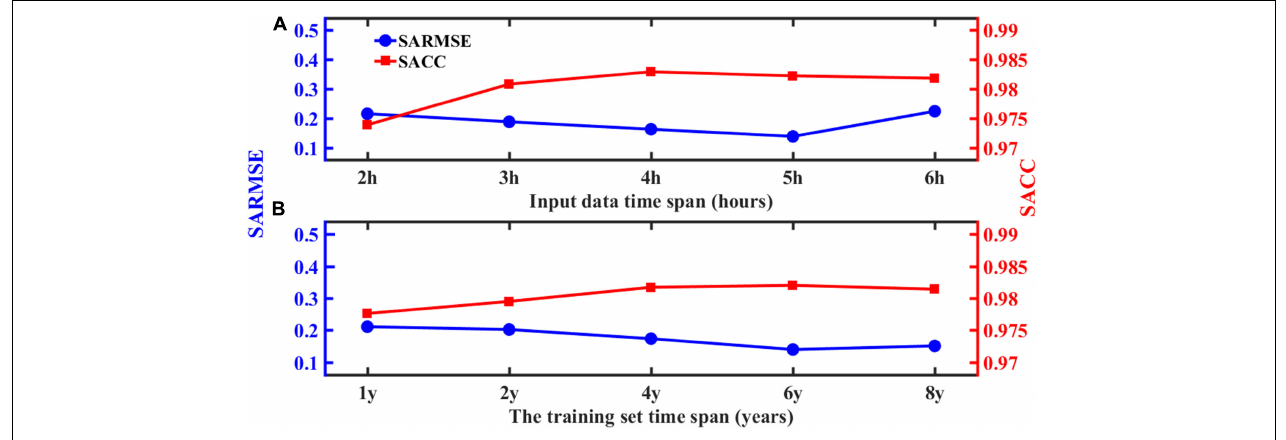
FIGURE 7 | (A) Changes in SARMSE and SACC with the time span of the input data. (B) Changes in SARMSE and SACC with the time span of the training set